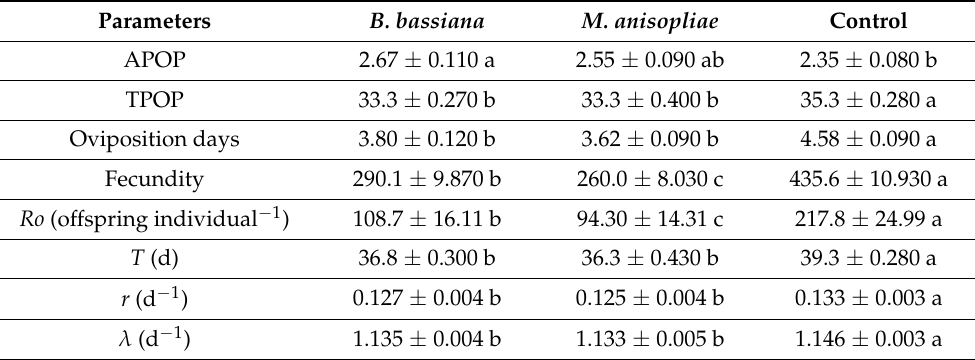
Figure 4. Age-stage-specific survival rate ( l x ), age-stage specific fecundity ( f xj ), age-specific fecundity ( m x ) and age-specific maternity ( l x m x ) of Spodoptera frugiperda fed on endophytic colonized and non-colonized plants. Table 2. Comparison of reproductive and life table parameters (mean ± SE) of Spodoptera frugiperda fed on maize plants colonized with Beauveria bassiana and Metarhizium anisopliae in comparison with untreated